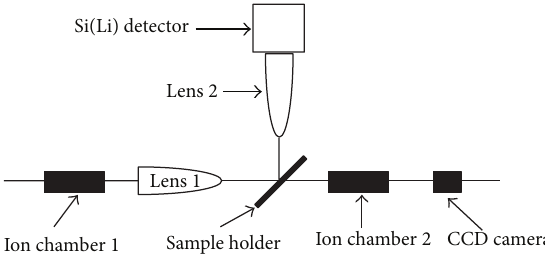
Figure 1: Experimental setup of the confocal spectrometer in the